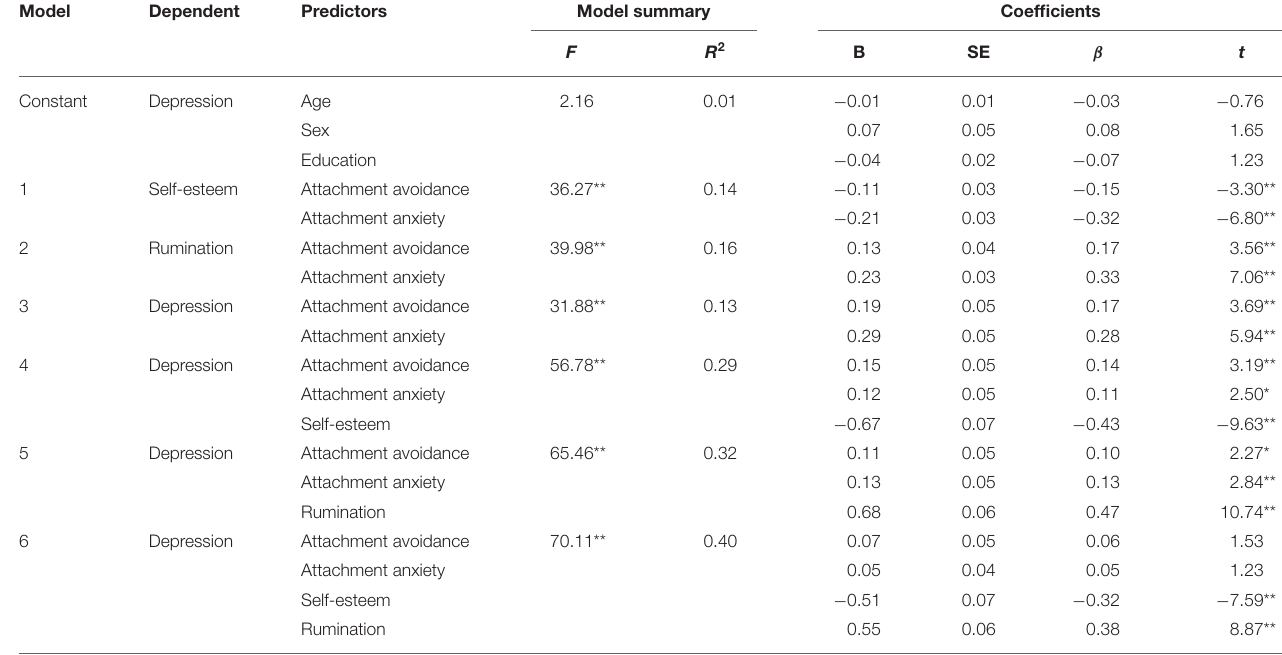
TABLE 2 | Regression analysis ( n =